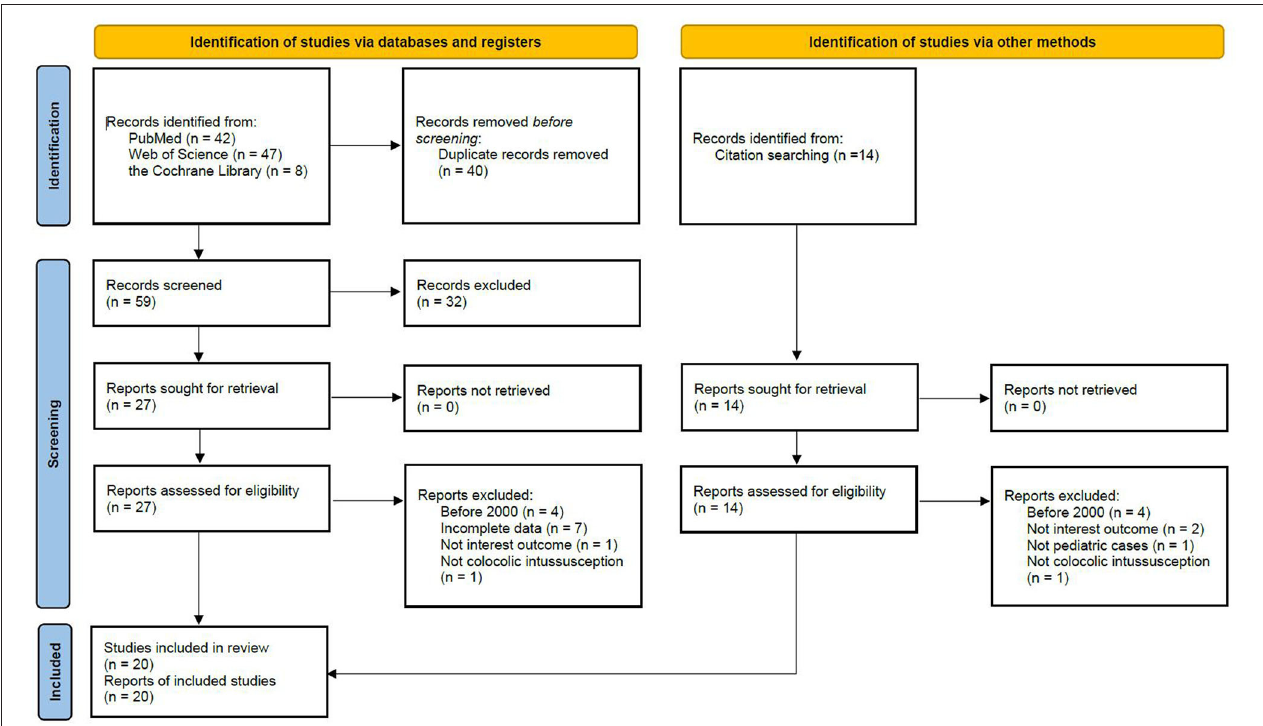
FIGURE 1 | PRISMA flowchart for study